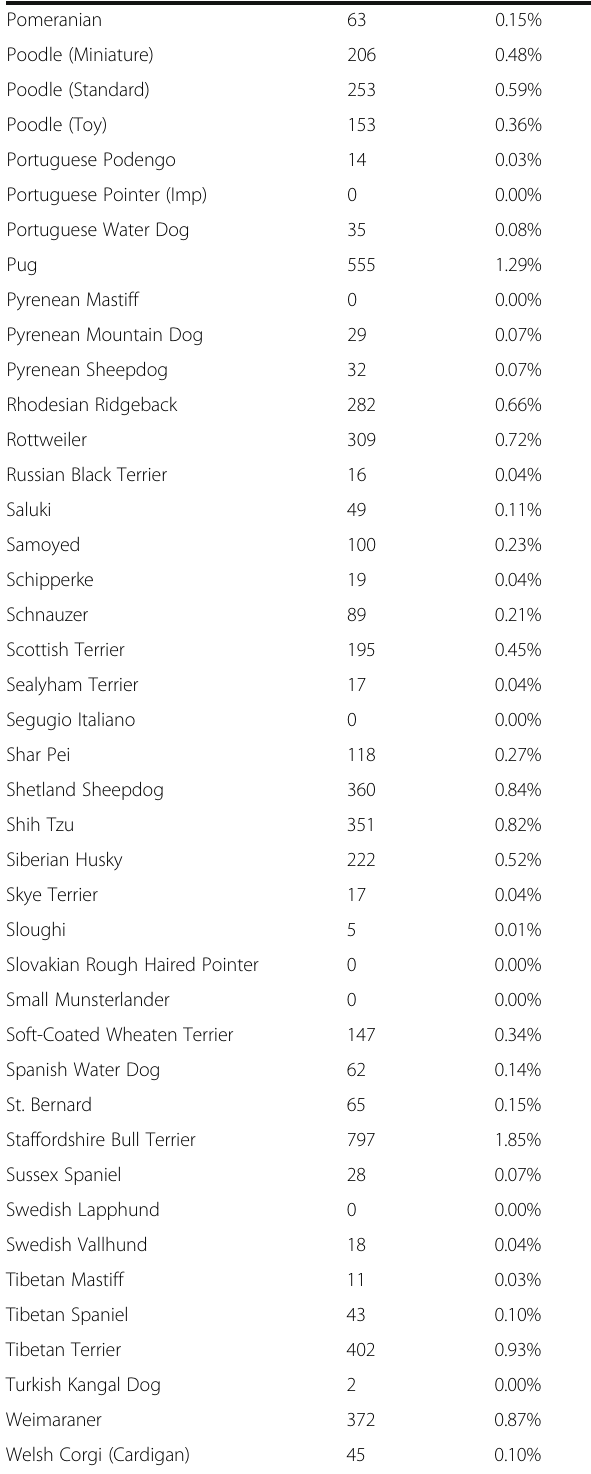
Table 1 Number of unique individual dogs for which responses were received and approximated response rate (from total number registered from 2004 – 13 inclusive) for all breeds (Continued)